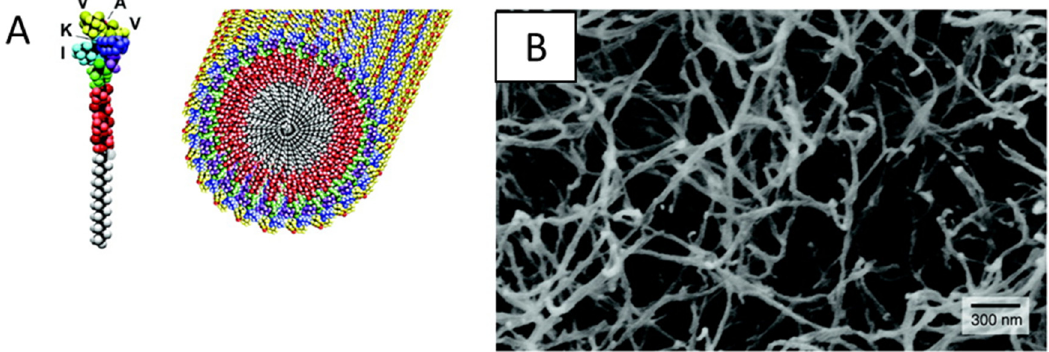
Figure 2. ( A ) Molecular model of a peptide amphiphiles (IKVAV) and ( B ) SEM images of a self-assembling peptide–amphiphile nanofiber network. Reproduced with permission from [64]. Copyright 2004,